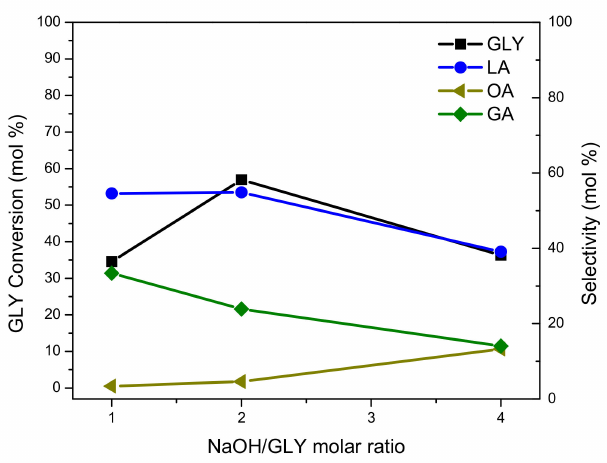
Figure 9. GLY conversion and oxidation products selectivity vs. NaOH/GLY molar ratio in GLY oxidation of the Pt-ZSM-11